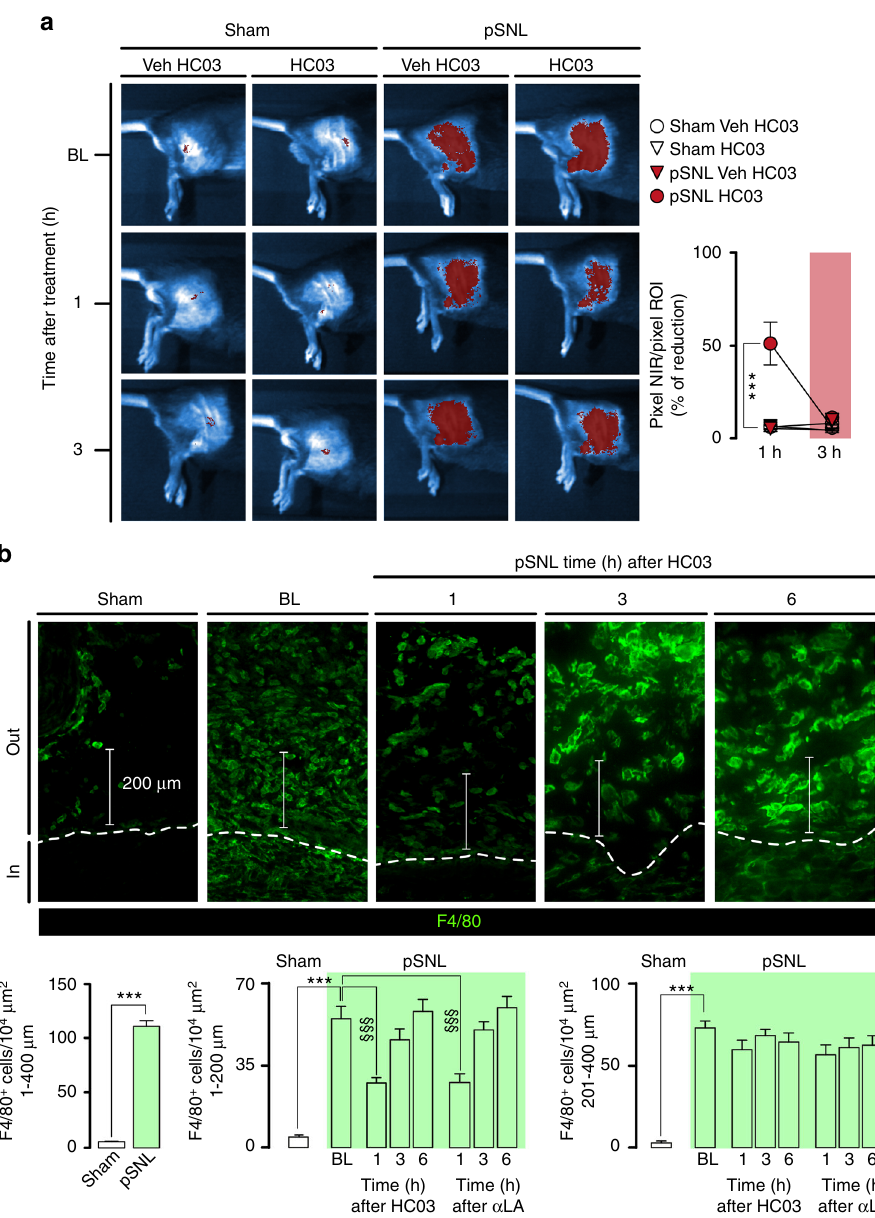
Fig. 7 TRPA1 blockade and antioxidant reduced the number of fl uorescent macrophages accumulated at the site of pSNL. a In vivo imaging and quantitative data (NIR area/total ROI) of NIR labeled macrophages (at day 10 after surgery) in sham/pSNL mice at baseline (BL), 1 and 3 h after HC-030031 (HC03, 100 mg kg − 1 , i.p.) ( n = 4, *** P < 0.001 pSNL HC03 vs. pSNL Veh HC03; two-way ANOVA followed by Bonferroni post hoc analyses). b Representative images and F4/80 + -cell number surrounding the injured nerve trunk (at day 10 after surgery) of sham/pSNL-mice at BL and 1, 3 and 6 h after HC03 or alpha-lipoic acid ( α LA) (both, 100 mg kg − 1 , i.p.). ( n = 4, *** P < 0.001 pSNL vs sham; §§§ P < 0.001 pSNL HC03, α LA vs. pSNL veh; one-way ANOVA followed by Bonferroni post hoc analyses) (Scale bars, 200 µ m; inside (in) and outside (out) sciatic nerves). Data are represented as mean ± Experimental design . C57BL/6, Trpa1 + / + or Trpa1 − / − , Trpv1 + / + or Trpv1 − / − , randomly allocated to the treatment group with i.p. administration of Partial ligation of the sciatic nerve . Partial ligation of the sciatic nerve (pSNL) TRPA1 selective antagonists, HC-030031 (HC03) or A-967079 [(1 E ,3 E )-1-(4- was performed in C57BL/6, in Trpa1 + / + or Trpa1 − / − , in Trpv1 + / + or Trpv1 − / − , in Trpv4 + / + or Trpv4 − / − and in Plp1-Cre ERT ;Trpa1 fl / fl or control mice as previously described 69 . Brie fl y, mice were anesthetized with i.p. injection of a mixture of ketamine (90 mg kg − 1 ) and xylazine (3 mg kg − 1 ), the right sciatic nerve was exposed, and a partial ligation was made by tying one-third to one half of the dorsal portion of the sciatic nerve. In sham-operated mice, used as controls, the right sciatic nerve was exposed, but not ligated. Mice were monitored, adequately rehydrated, and maintained in a controlled temperature (37 °C) until fully recov- ered from anesthesia.